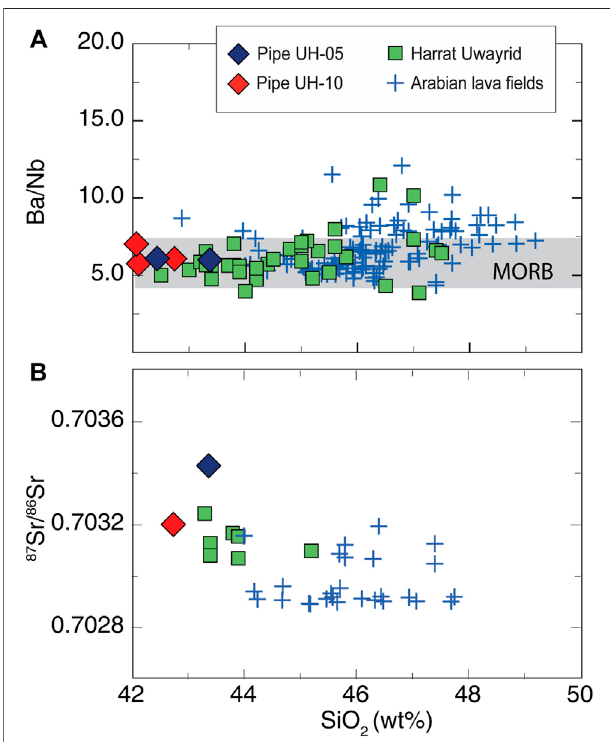
FIGURE 9 | Covariations of Ba/Nb vs. SiO 2 (A) and of 87 Sr/ 86 Sr vs. SiO 2 (B) ofbasaltsfrom Harrat Uwayrid (this workand Altherr et al., 1990)and from Marthoum pipes, overimposed to basalt compositions from other Arabian lava fi elds (Moufti et al., 2012; Duncan and AlAmri, 2013; San fi lippo et al., 2019) and to the MORB fi eld (Hoffman, 1997).